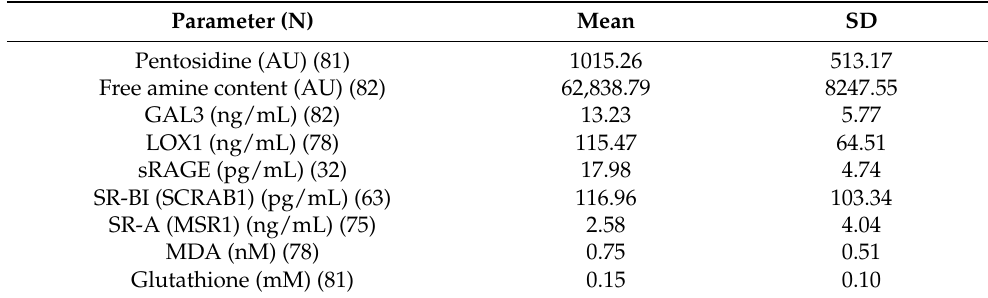
Table 2. Mean contents and standard deviation of the analyzed parameters in the serum of the studied geriatric